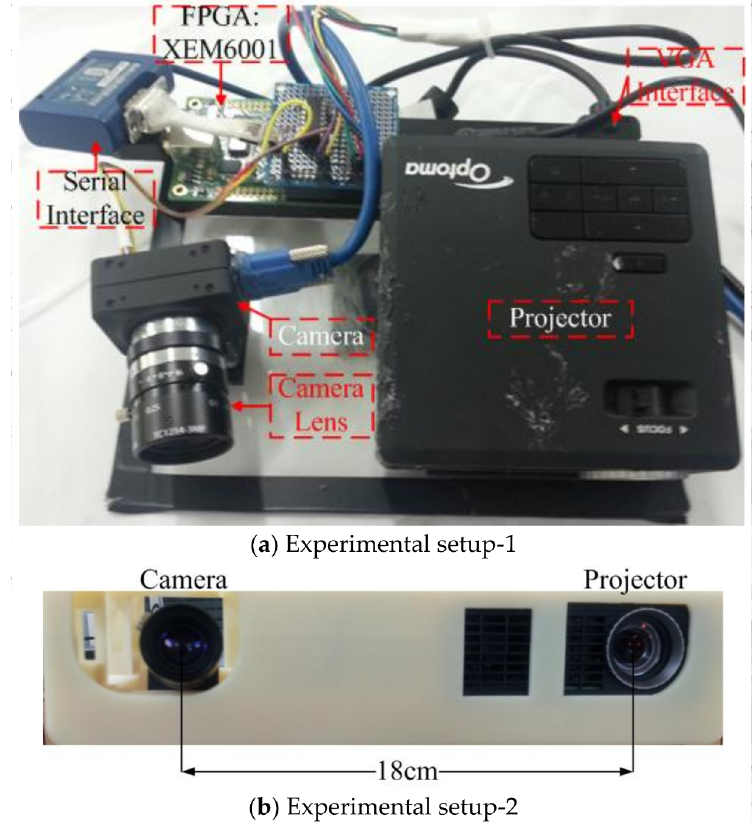
Figure 14. Experiments are performed on two different camera setups ( a ) Chameleon USB 3.0 camera with an Optoma ML 750 commercial projector; and ( b ) Flea3 FireWire with an Optoma ML 750